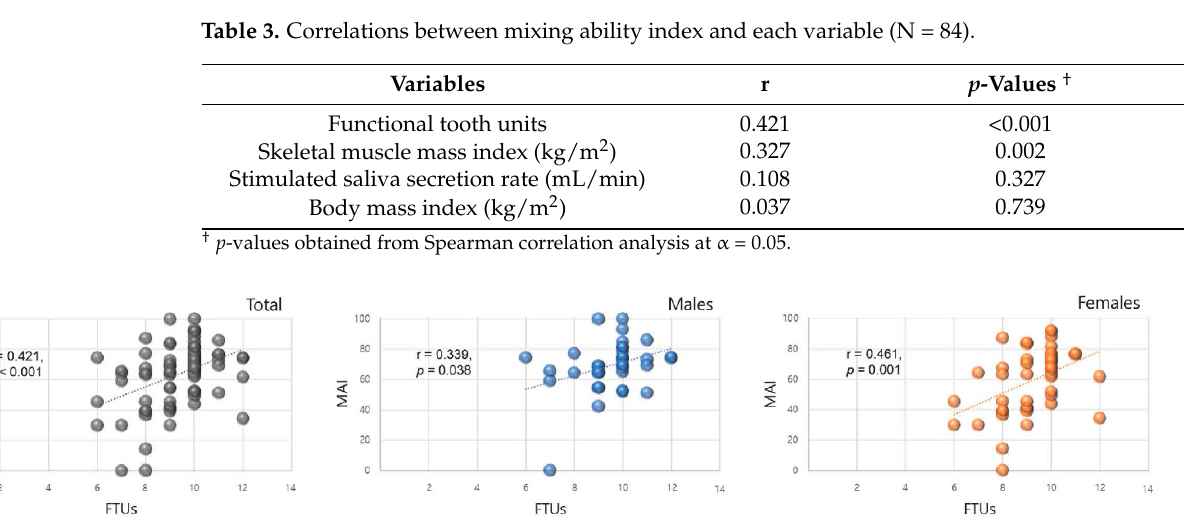
Figure 2. Correlation between functional tooth units (FTUs) and the mixing ability index (MAI).